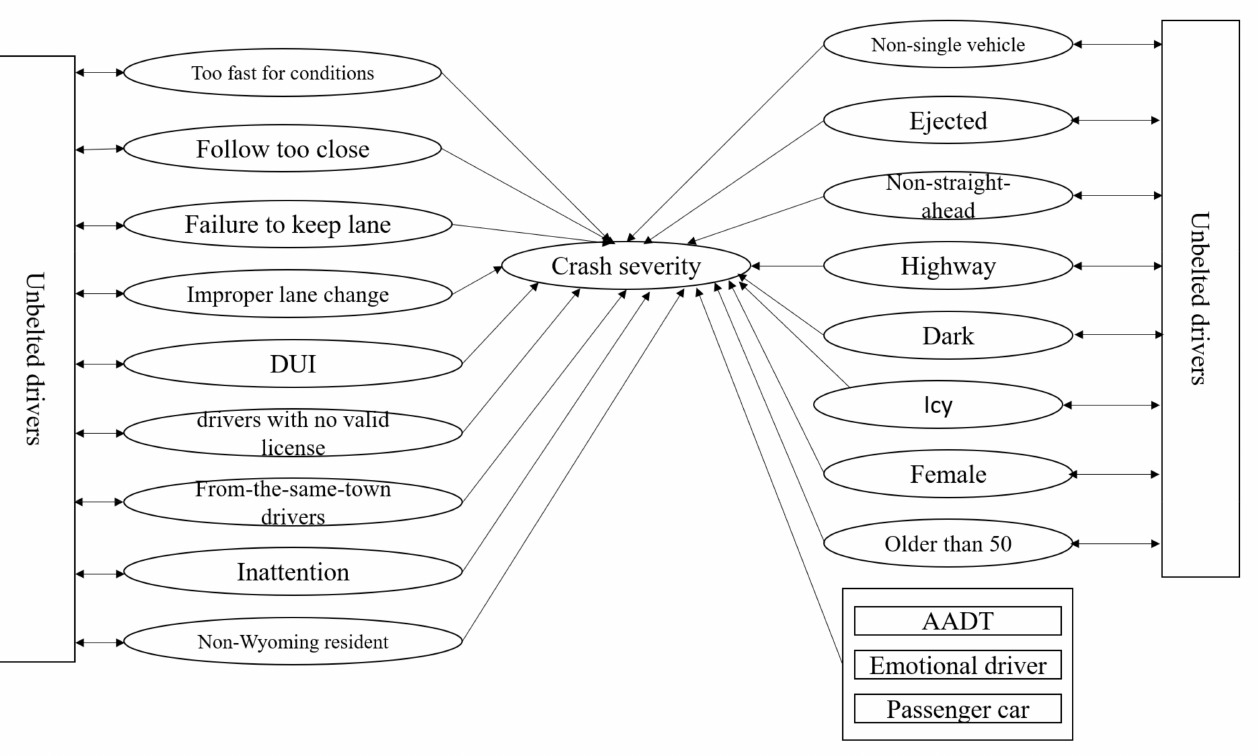
Figure 1. Complex relationship between seatbelt use and other predictors. The double arrows highlight the interactive variables with seatbelt